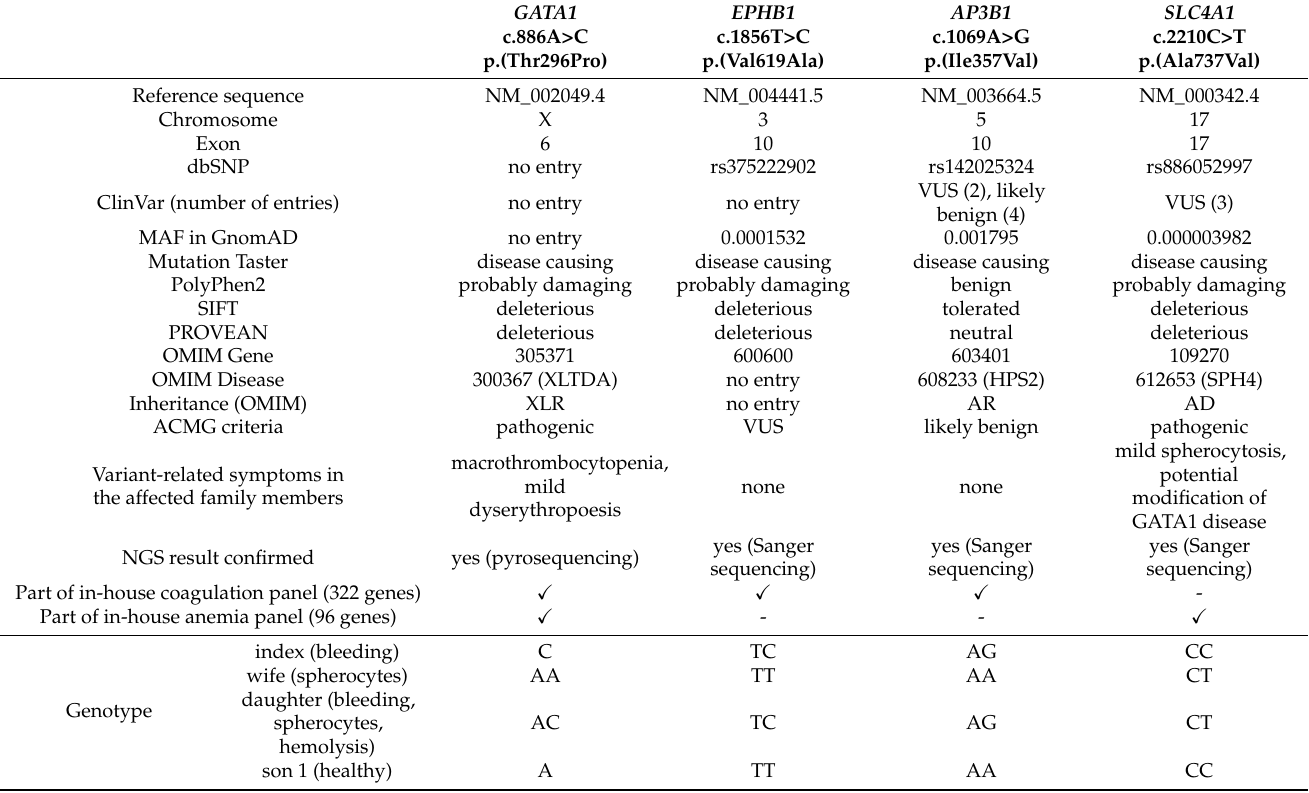
Table 2. Comparison and classification of filtered potentially disease-causing variants detected by exome